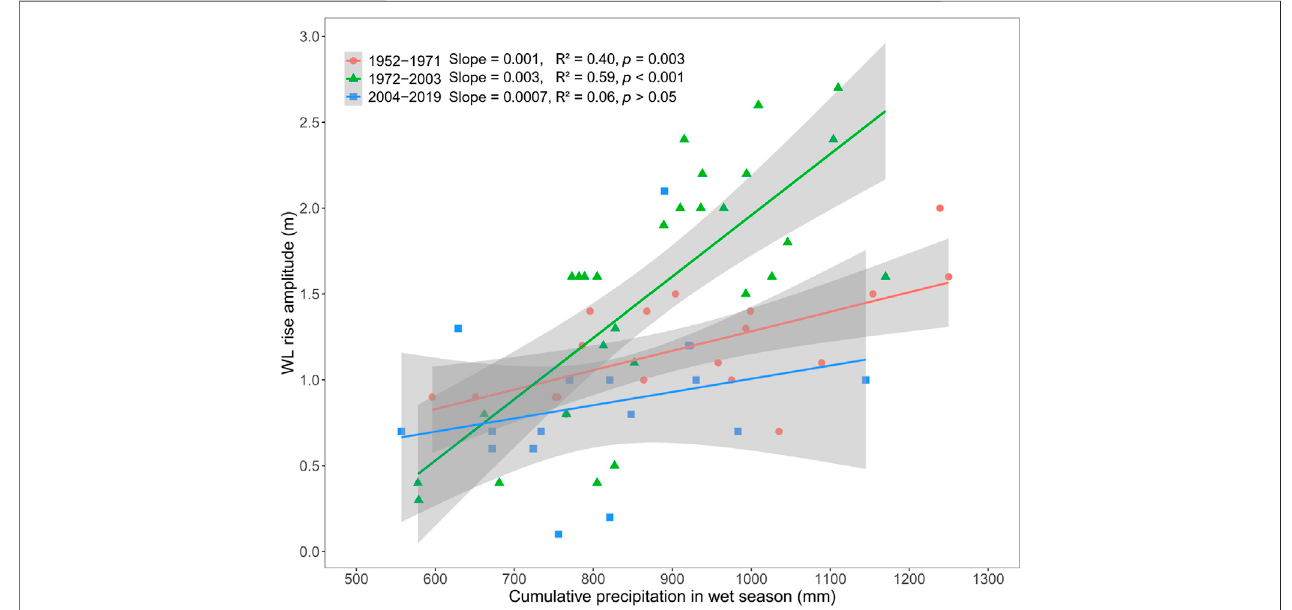
FIGURE 8 | Increase in water level (WL) plots against amount of cumulative precipitation in same wet season (May – October) in 1952 – 1971, 1972 – 2003, and 2004 – 2019 periods. Dots are yearly data.